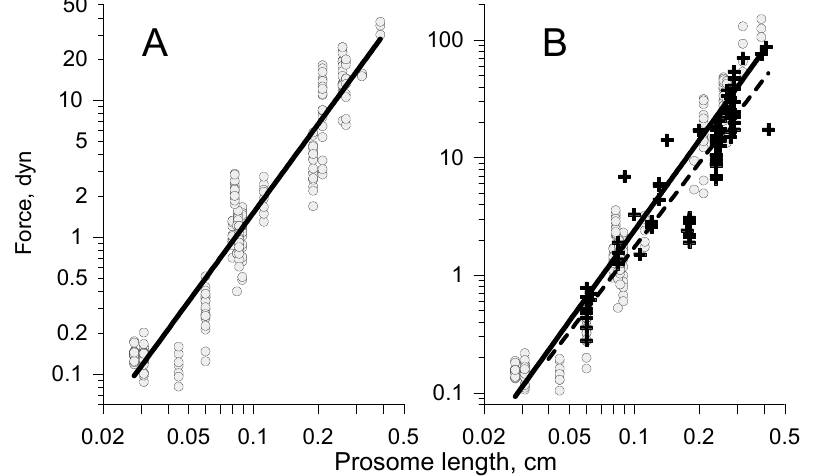
Figure 17. ( A ): Drag force; R d = 211.6 L 2.15 (R 2 = 0.91, N = 241). ( B ): Propulsive force, calculated ( ○ ) for free swimming copepods and directly measured ( + ) in attached individuals during an escape reaction; R p = 838.2 L 2.55 (R 2 =0.94) and R p,att = 408.6 L 2.37 (R 2 = 0.82, N = 88).